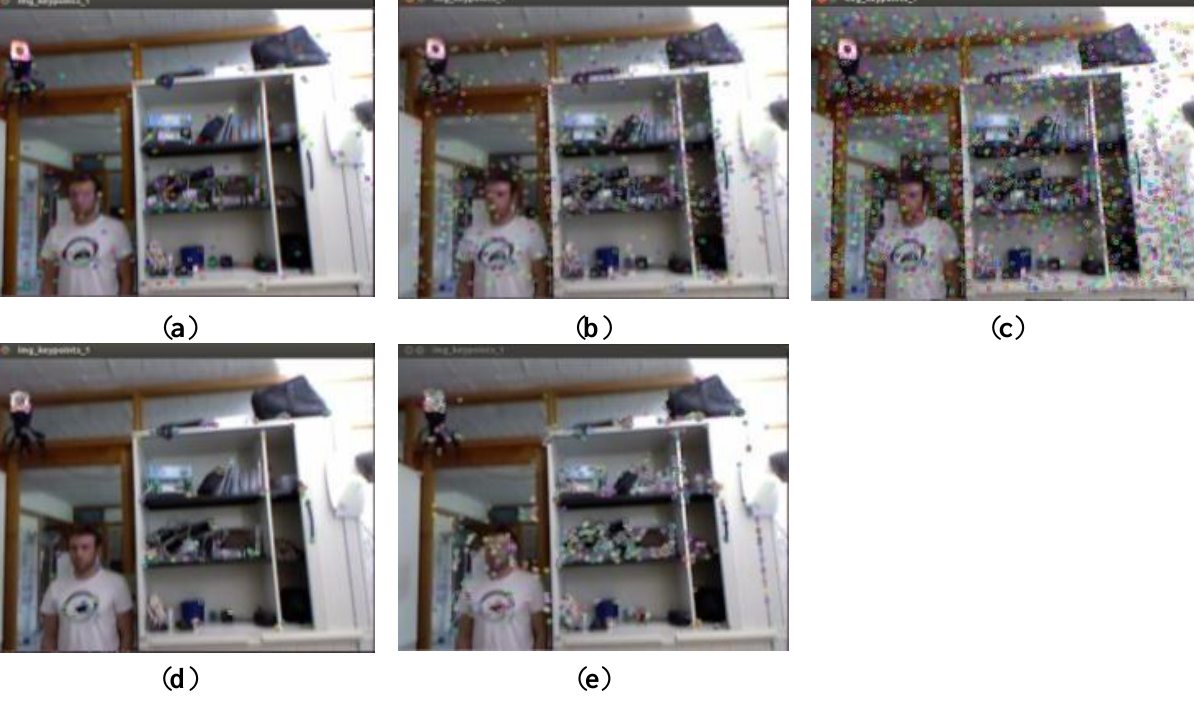
Figure 4. Results of 337th RGB image in datasets for feature detection and